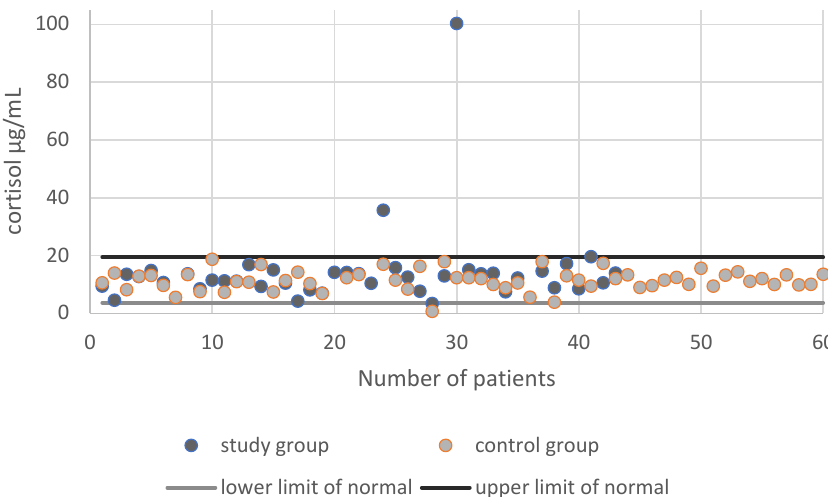
Figure 3. The cortisol concentration in the study group and in the control group.